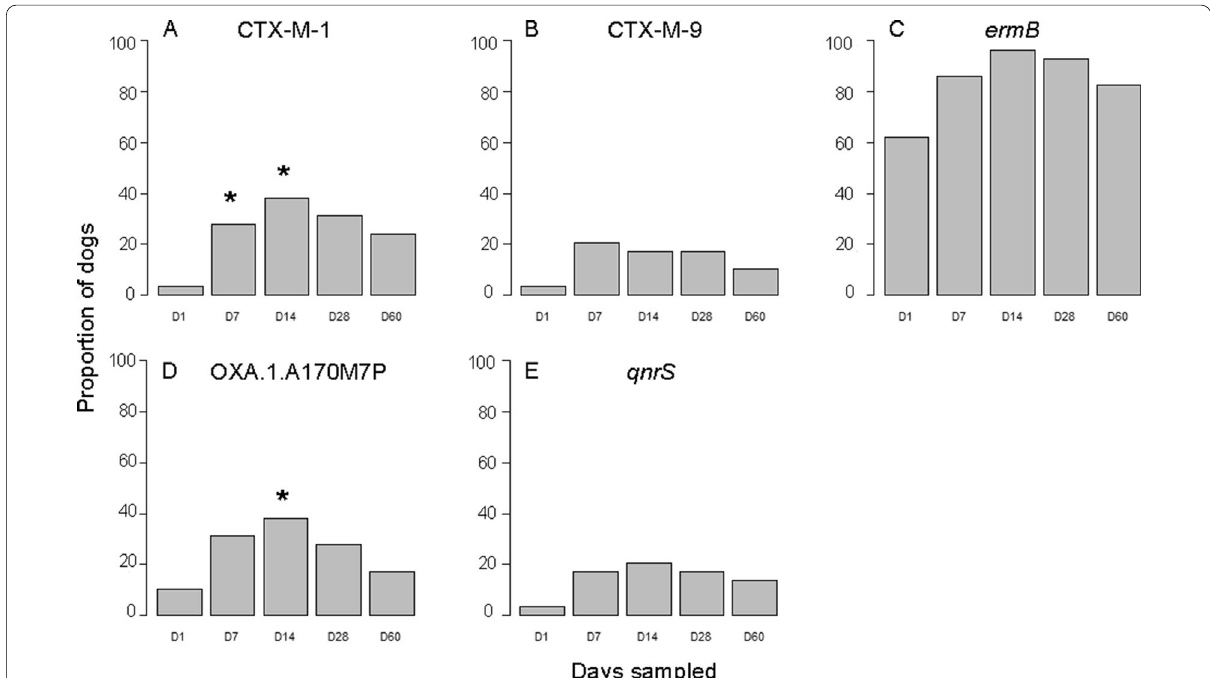
Fig. 6 Bar histogram showing the proportion of dogs in which a resistant gene was recovered compared to the all the dogs at the different time points. Frequency of recovery of resistance gene was compared between peak time point and D1 using the McNemar test. * P